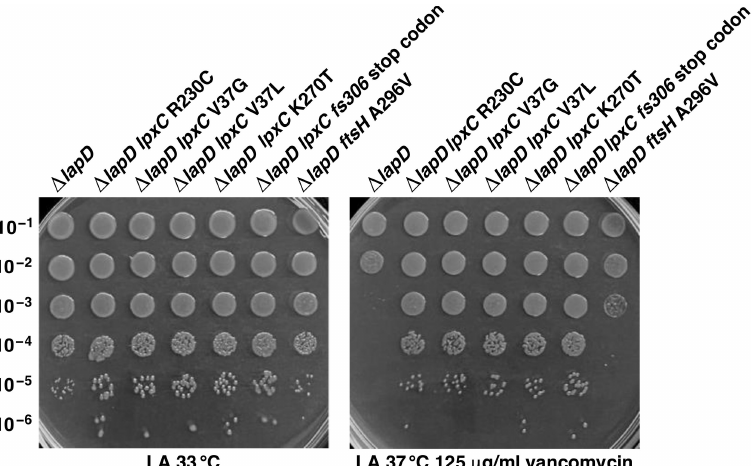
Figure 6. Mutations that stabilize LpxC suppress vancomycin sensitivity of ∆ lapD bacteria. Growth of isogenic cultures of strains with ∆ lapD and with suppressor mutations in the lpxC gene was quantified by spot dilution on LA with and without supplementation of vancomycin. The relevant genotype and temperature of incubation are